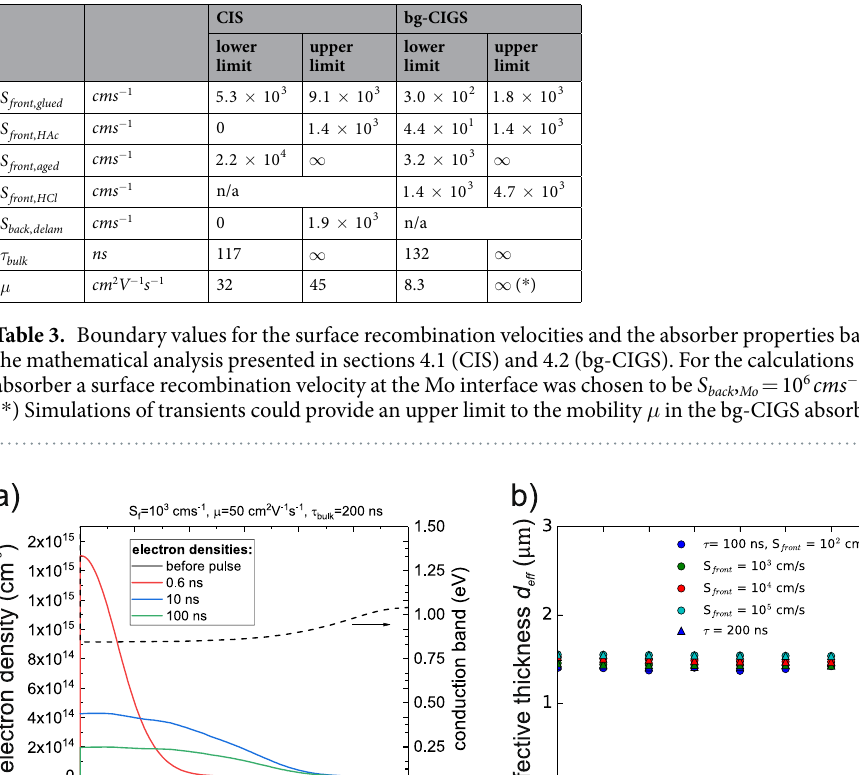
μ τ S S , , , . The simulated decay times were used in the front back bulk 1 a solution of the effec- parameters and = − S cms 0 back front bulk μ = . d m 1 5 was used and S back eff